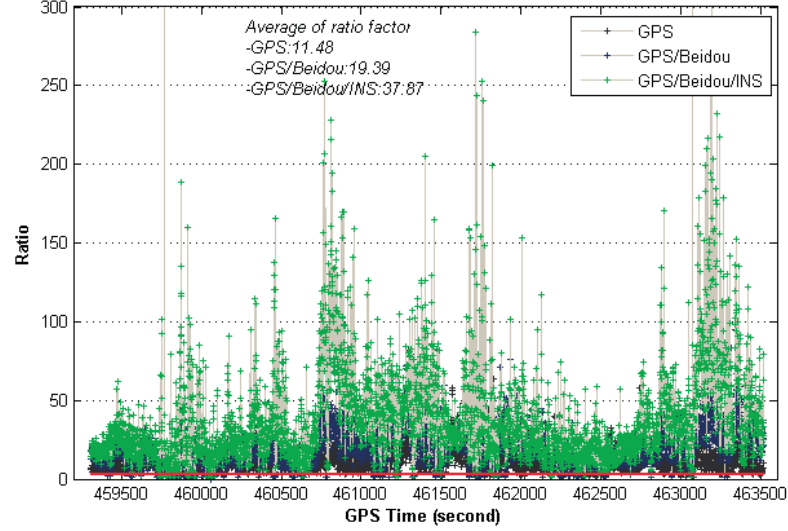
Figure 11. Ratio values of instantaneous AR for different system configurations (20° cut-off